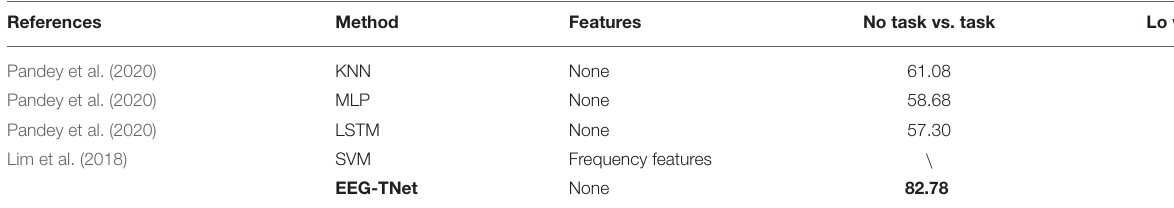
TABLE 3 | Comparisons of the estimation accuracy (%) of subject-independent experiments among the various methods.